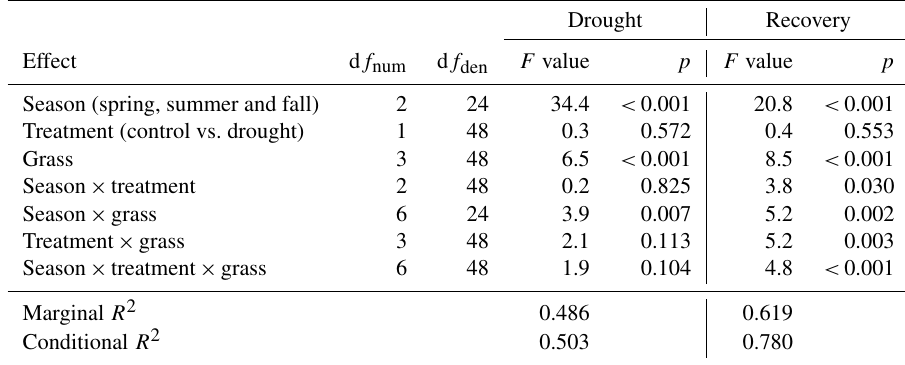
Table A1. Summary of analysis for the effects of season, drought treatment, grass and their interactions on root biomass in 2014 (root dry weight; naturally log transformed) at the end of each drought treatment (drought) and after 6 to 8 weeks after drought release (recovery). The inference ( F and p values) refers to the fixed effects of the linear mixed model. d f num – degrees of freedom term; d f den – degrees of freedom of error.